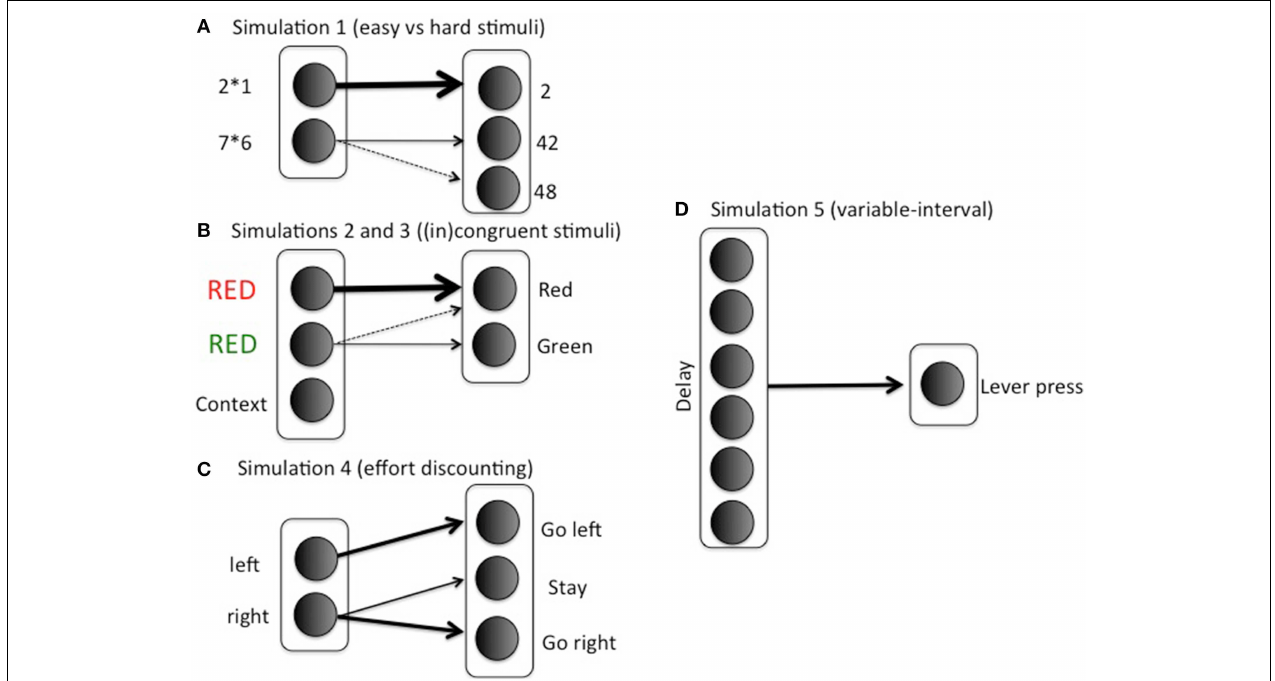
FIGURE 3 | Simulation-specific stimulus-action